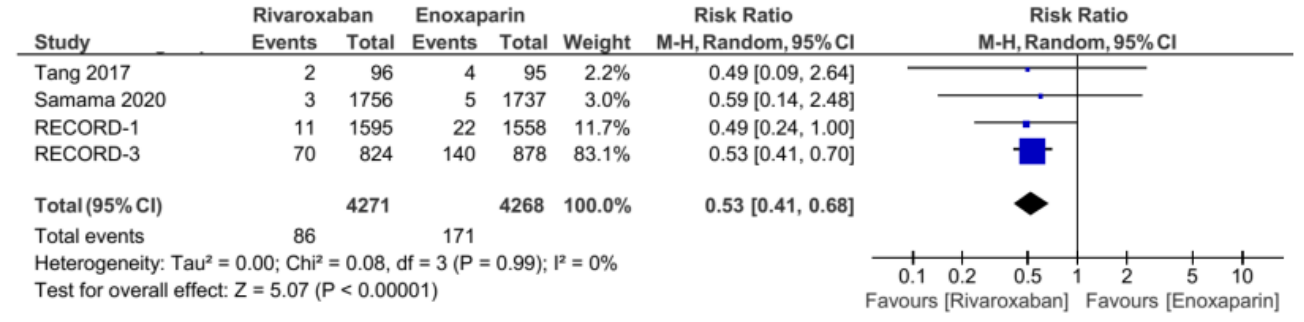
Figure 3. Incidence of distal DVT [5,7,13,14].